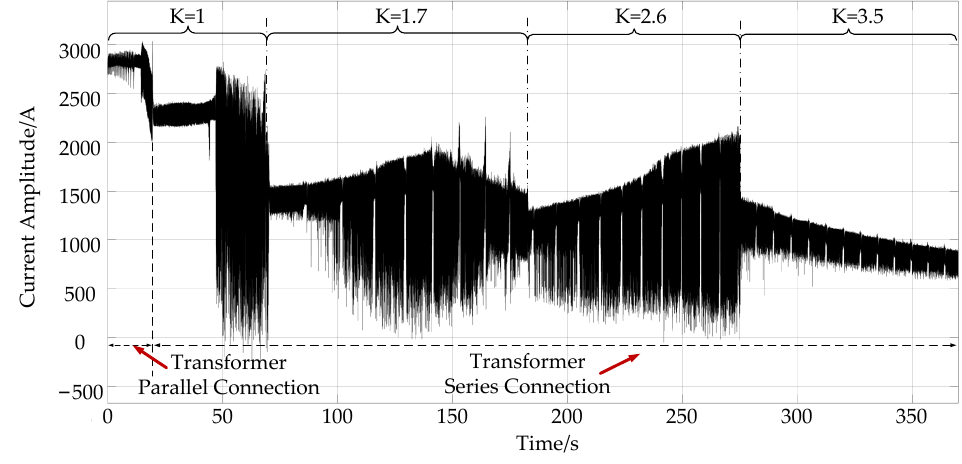
Figure 15. The q -axis current of the left stator winding.